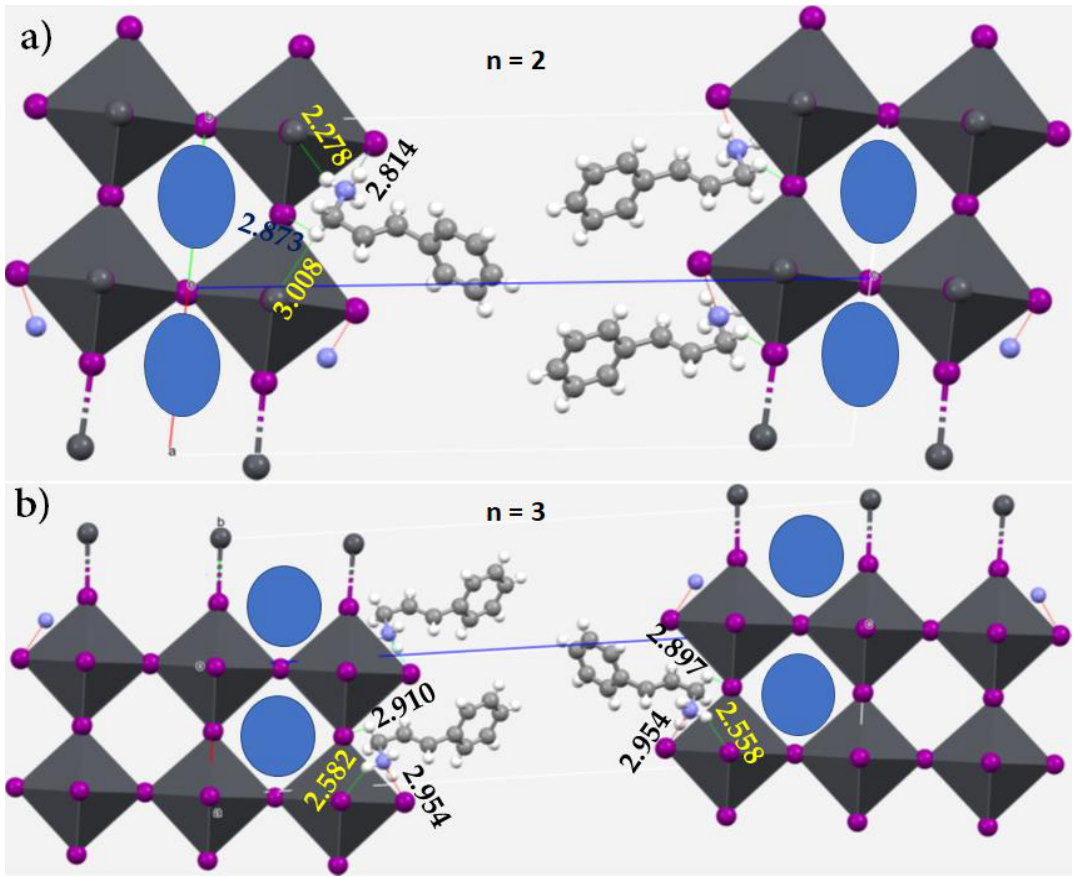
Figure 20. Polyhedral and ball-and-stick models of the crystal structure of (PPA) 2 (FA 0.5 MA 0.5 ) n −1 Pb n I 3 n +1 materials in 2D/3D: ( a ) n = 2 and ( b ) n = 3. Neither of these structures, as deposited in the CSD, show the correct orientation of the organic cations within the 3D perovskite cages, as provided in the supplementary material to the study [137], and hence we replaced them here by blue ellipses. The pnictogen bonded contacts are shown as dotted lines in cyan and the hanging contacts are in red. Selected intermolecular N ··· I, C–H ··· I and N–H ··· I bond distances and bond angles in Å and degrees,